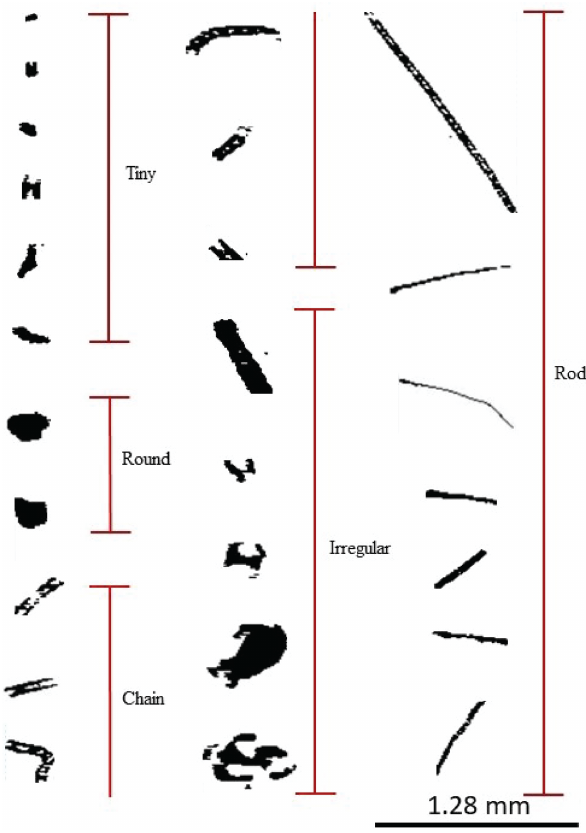
Figure 3. SAPs recorded within the BB plume by the 2D-S probe during the ORACLES 2017 campaign. SAPs were observed to be a variety of sizes and shapes, ranging from 10 to 1280µm in length. The figure shows the five primary shapes of SAPs observed during 30–31 August